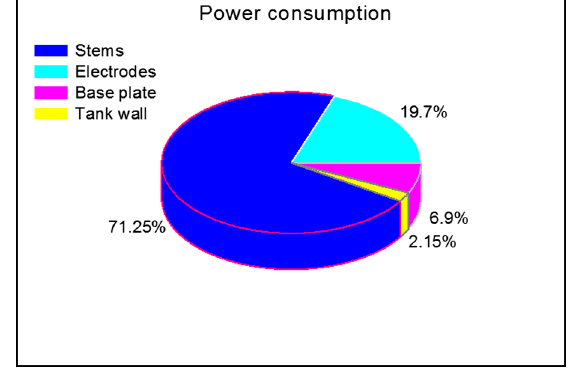
system.FIG. 13. Power consumption in the RFQ